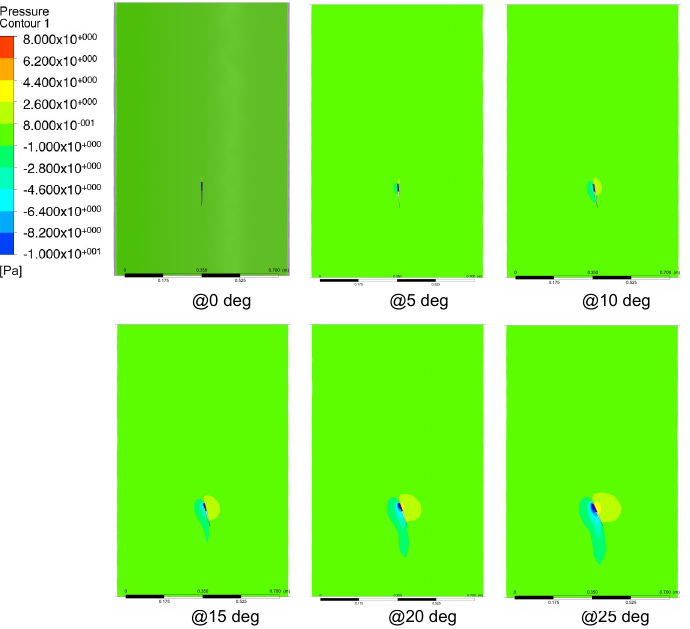
Figure 13. Pressure contours generated for an 80% MCR UAV v3.0 control-surface chord with angles of deflection from 5 to 25 degrees for Aileron